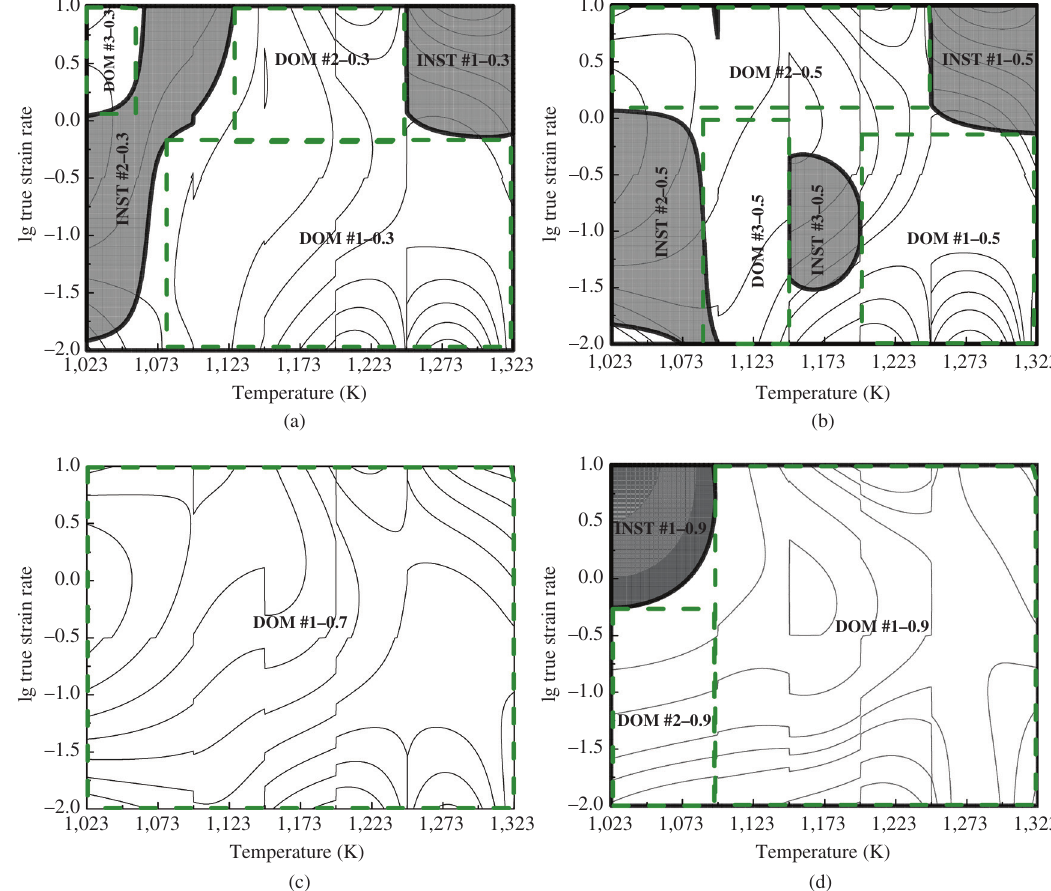
Figure 9 : Processing maps as the true strain: (a) " ¼ 0 : 3 , (b) " ¼ 0 : 5 , (c) " ¼ 0 : 7 , (d) " ¼ 0 : 9